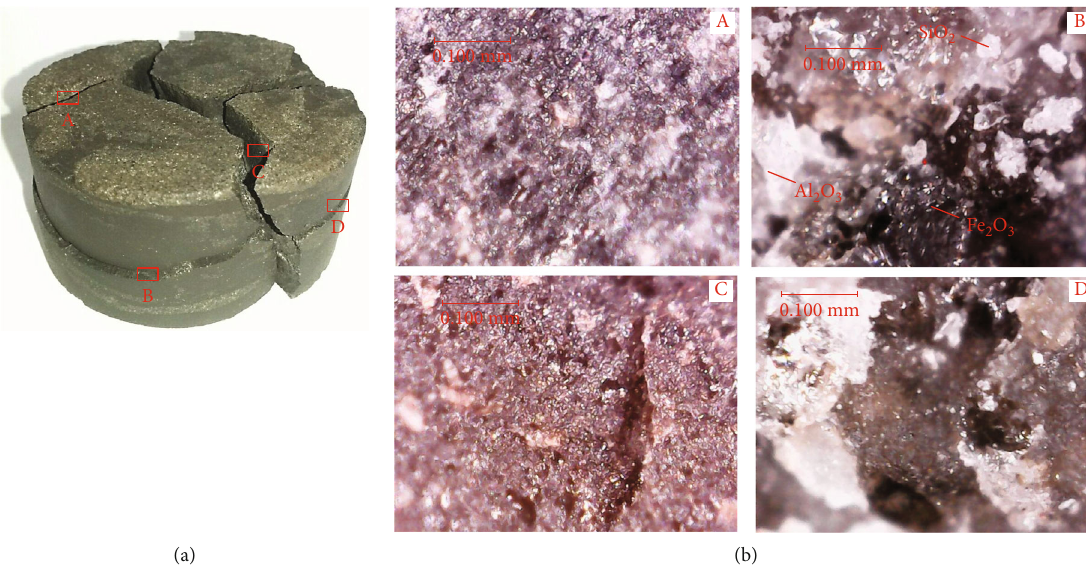
Figure 16: The crack characteristic of mudstone under impact loading: (a) axial splitting and axial tension crack locations numbered as A, B, C, and D, respectively; (b) crack micrograph under electron digital microscope ( ×